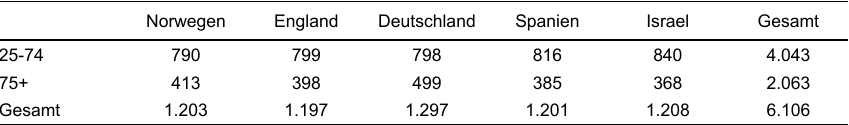
Tabelle 2: Die OASIS-Datenbasis: Surveystichprobe (25+ ubanen